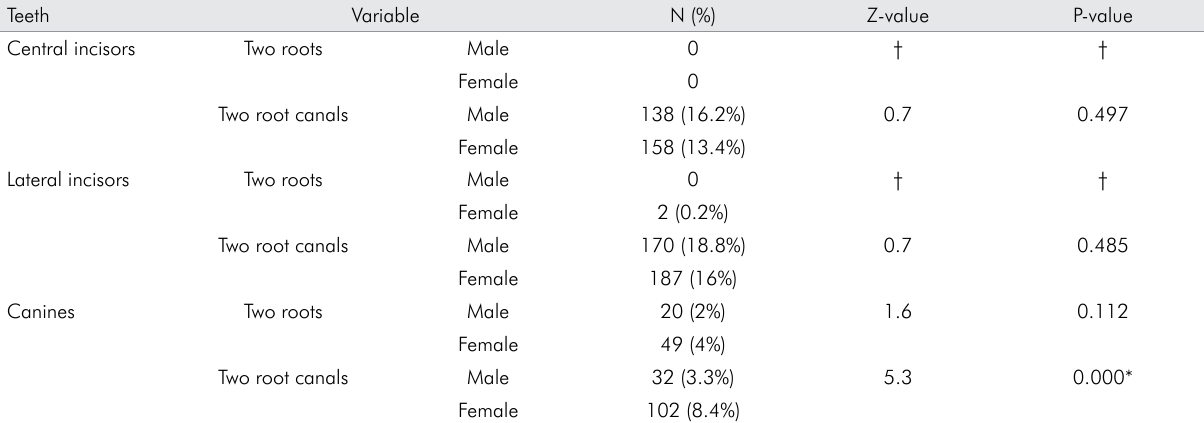
Table 2. Distribution of the mandibular anterior teeth with two roots or two root canals by gender, and statistical results. Values in parentheses signify the percentage within all teeth for the specified tooth type and gender.